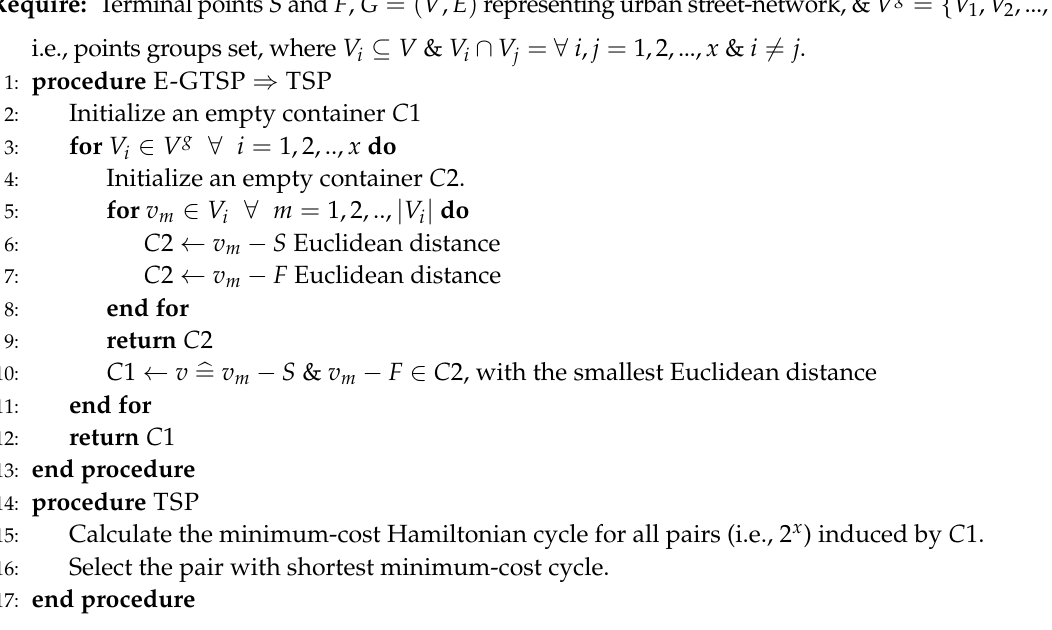
Algorithm 2 R-Search